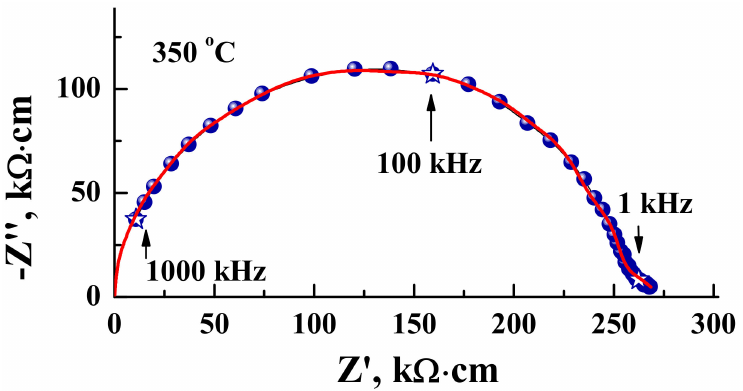
Figure 3. The Nyquist-plot for the BaNd 2 In 2 O 7 ceramic material obtained at 350 ◦ C under dry